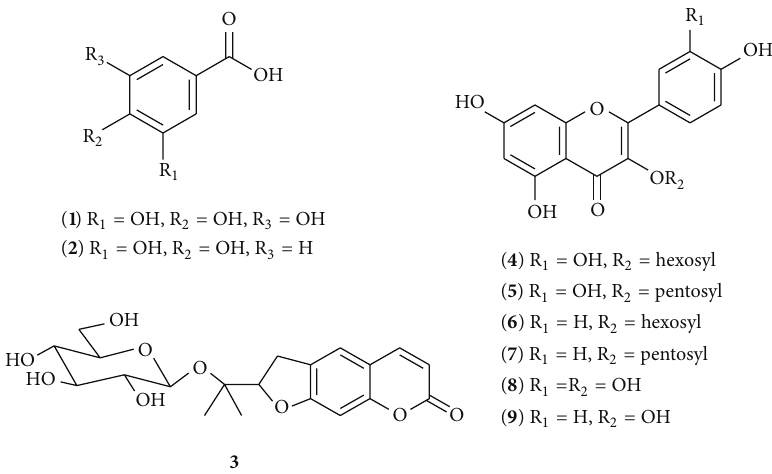
Figure 2: Structures of the eight polyphenols and one nodakenin in Euphorbia supina.